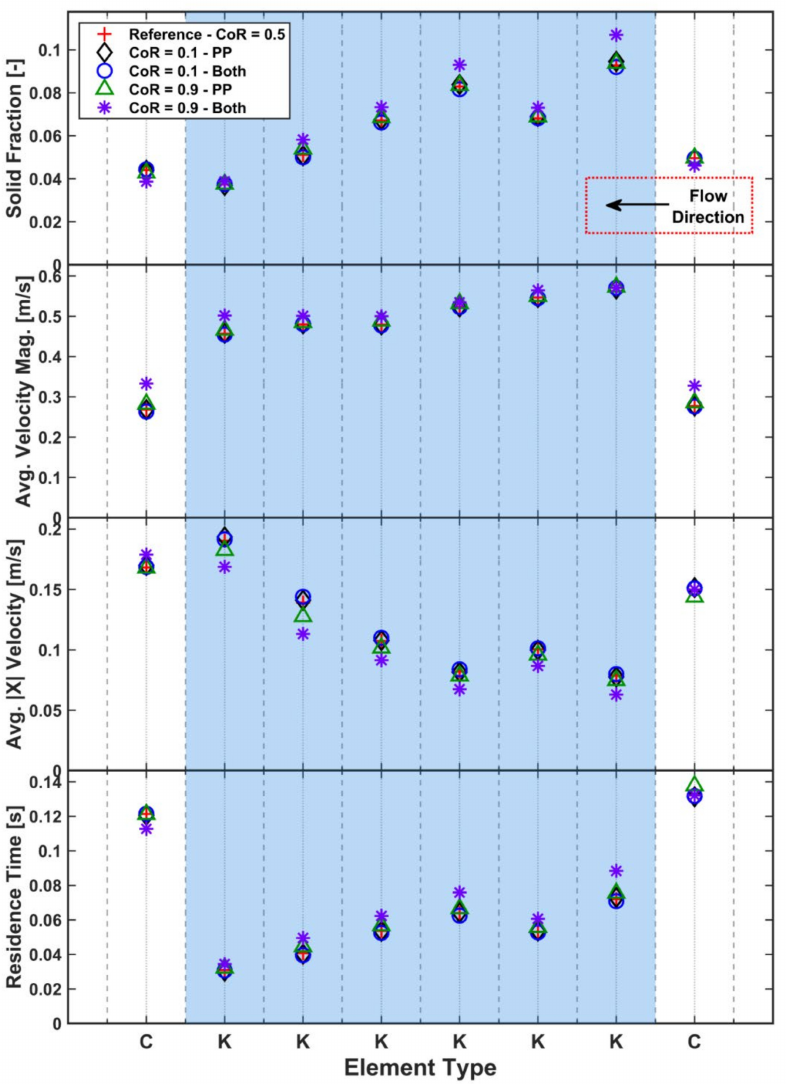
Figure 13. Effect of coefficient of restitution on solid fraction, velocity and residence